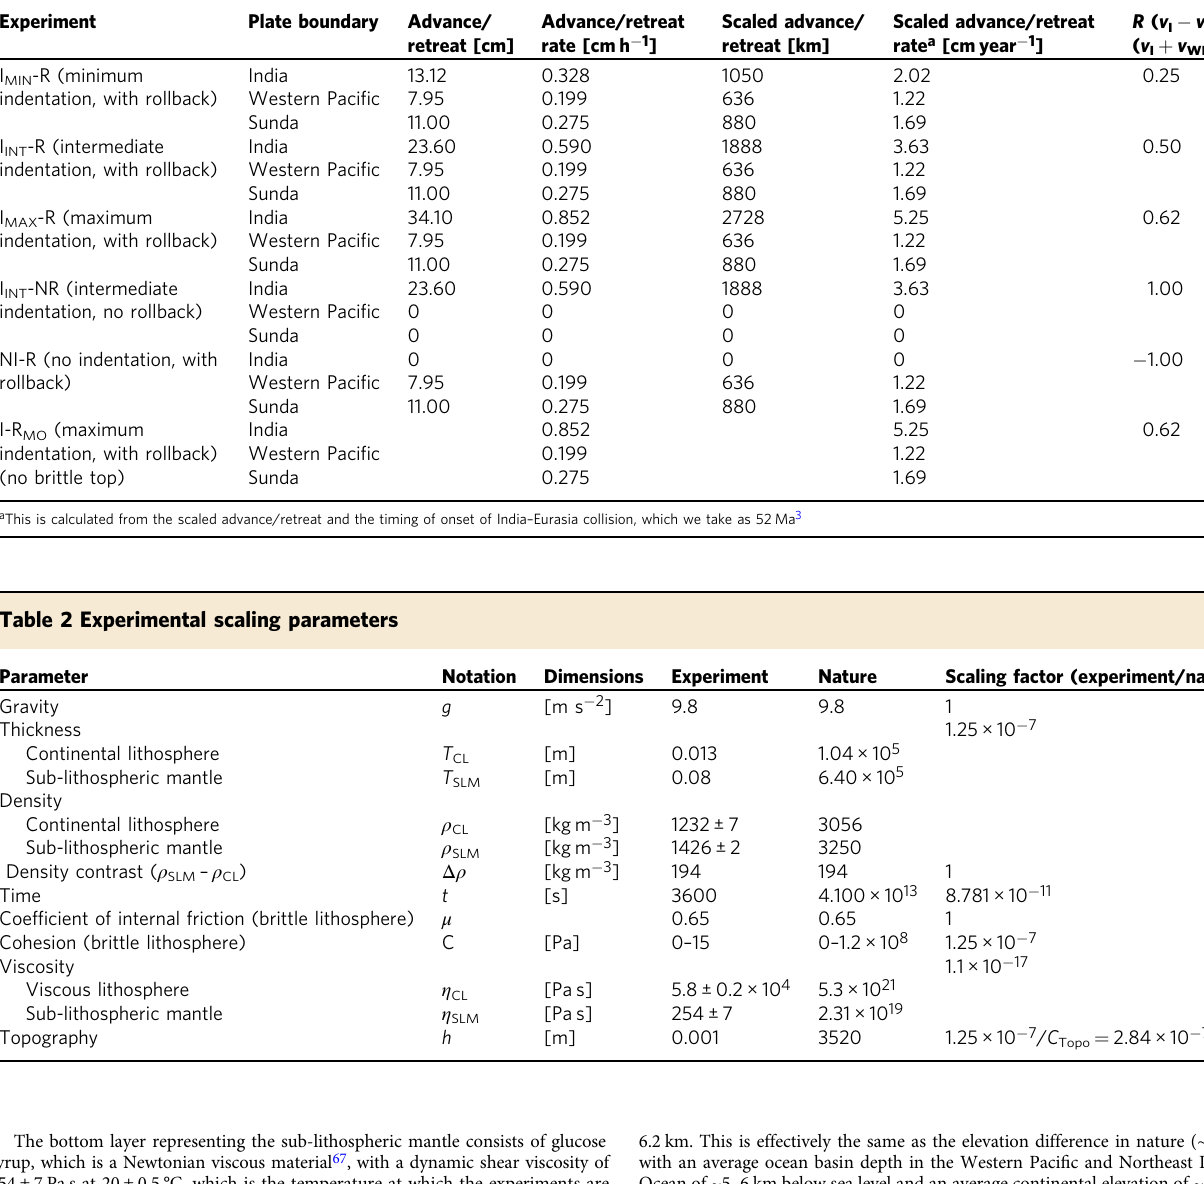
The bottom layer representing the sub-lithospheric mantle consists of glucose syrup, which is a Newtonian viscous material 67 , with a dynamic shear viscosity of 254 ±7 Pas at 20± 0.5°C, which is the temperature at which the experiments are conducted. With a viscosity scaling factor of 1.1× 10 − 17 , the experimental sub- lithospheric upper mantle viscosity represents 2.3× 10 19 Pas in nature, which is in general accordance with values estimated previously 68 – 70 , which are of the order 10 19 – 10 20 Pas. Dynamic scaling requires that the experiments are conducted in the same fl ow regime as in nature 56 (laminar fl ow regime with dihedral symmetry across two orthogonal planes), which demands that the Reynolds number Re<<1, with Re = ρ vd / η . Here ρ is the density of the ambient fl uid (1426 kgm − 3 for the sub- lithospheric mantle), v is the characteristic velocity (we take the velocity of the and η is the dynamic shear viscosity of the ambient fl uid (254 Pas for the sub- lithospheric mantle). This gives an experimental Re = 2.7× 10 − 6 <<1. Considering that the experiments are scaled for gravity, that the Asian continental lithosphere is isostatically supported and that there are lateral density differences between the continental and oceanic domains, there are elevation differences and gravitational potential energy differences in the experiments. The average density of the continental Asian lithosphere is lower than that of the oceanic domains, and therefore its elevation and potential energy are higher than that of the surrounding oceanic domains. With a length scaling factor of 1.25 × 10 − 7 in our models and a C Topo = 0.44, we calculate that the elevation of the